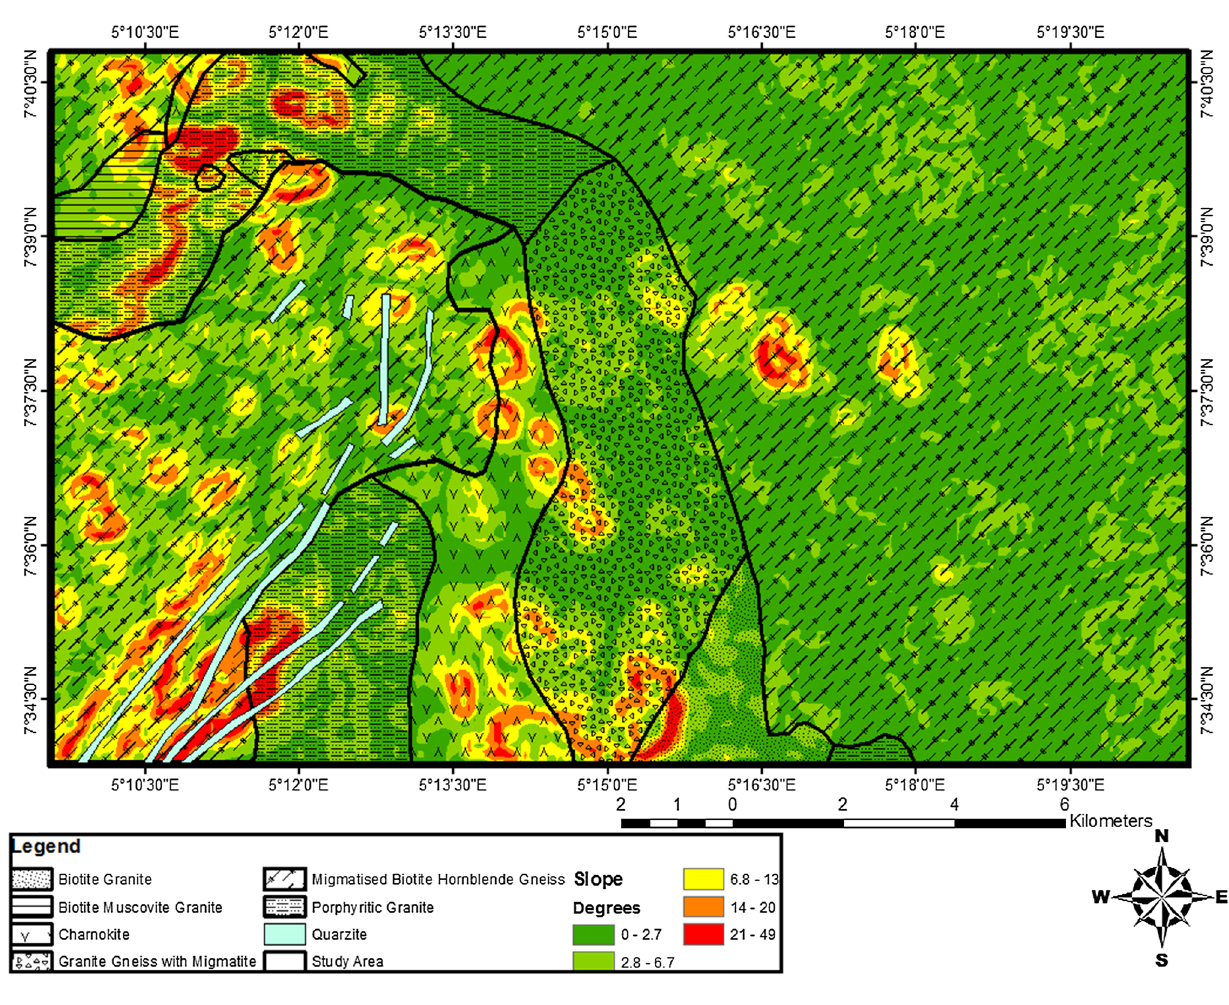
Fig. 8 Slope map of the study area Table 2 Classification of slope in the study area (Talabi and Tijani 2011)